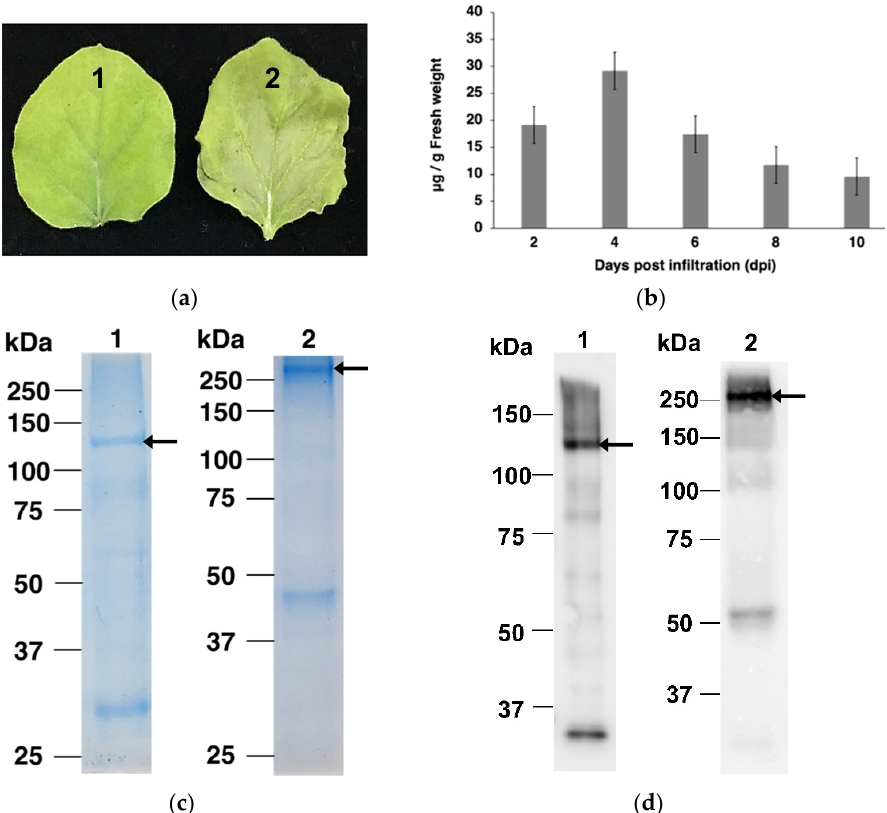
Figure 2. Expression and characterization of plant-produced SARS-CoV-2 S1-Fc protein. ( a ) The phenotype of wild-type leaves (1) and Agrobacterium -infiltrated leaves with pBYR2e-SARS-CoV-2 S1-Fc after 4 dpi (2). ( b ) Optimization of SARS-CoV-2 S1-Fc protein expression in N. benthamiana leaves performed on days 2-, 4-, 6-, 8-, and 10 after agroinfiltration using ELISA. The data are provided as the mean ± SD of three replicates. ( c ) SDS-PAGE analysis of purified SARS-CoV-2 S1-Fc protein produced in plants stained with InstantBlue™ and ( d ) Western blot analysis of purified plant-produced SARS-CoV-2 S1-Fc protein probed with anti-human gamma-HRP conjugate antibody. The SARS-CoV-2-S1-Fc protein purified from plants was loaded in Lane 1 and 2 under reducing and non-reducing conditions, respectively.